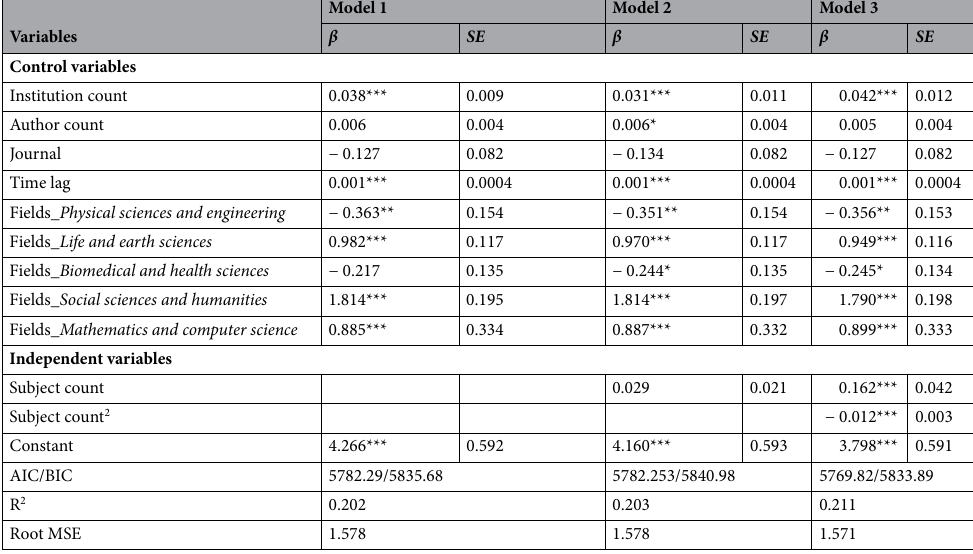
Table 3. Regression analysis results. Robust standard errors are in parentheses; *** p < 0.01, ** p < 0.05, * p < 0.1.